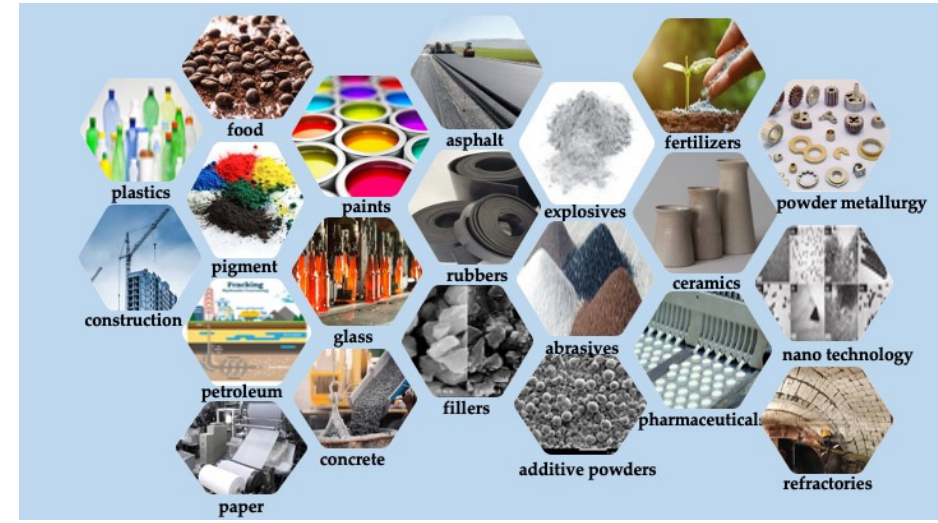
Figure 1. Particle-based industries.